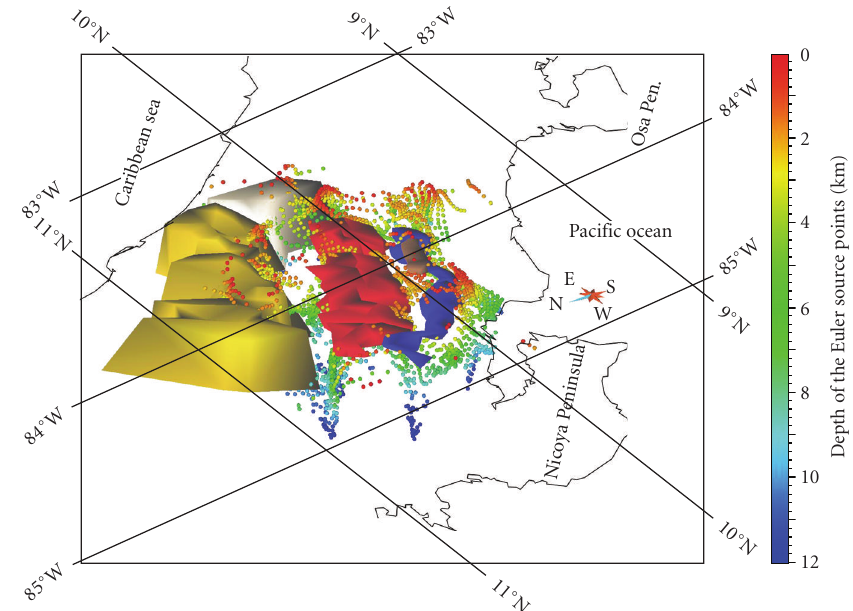
Figure 4: Semiperspective view of the modeled area. Colored dots show locations of Euler deconvolution source points relative to the modeled bodies. Main modeled bodies are shown as colored polyhedra. The yellow polyhedron represents the back arc structural high with a density of 2.82 Mg/m 3 . The red polyhedra represent the low-density zones beneath the arc with densities between 2.35 and 2.38 Mg/m 3 . The blue polyhedra represent the paleo-arc bodies with densities between 2.40 and 2.45 Mg/m 3 . Coastline is shown in black.